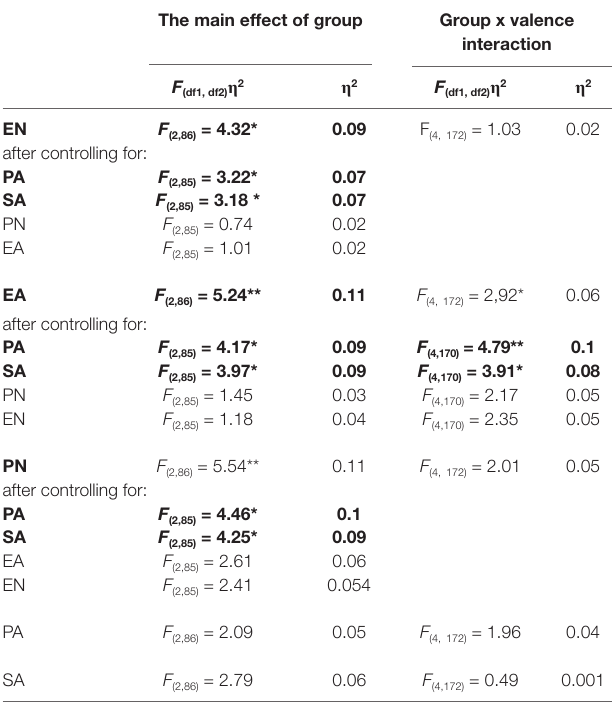
TABle 4 | The effect of specific childhood adversities on the response accuracy in RMET valences: results of 3(group) × 3(valence) mixed ANCOVAs. The main effect of